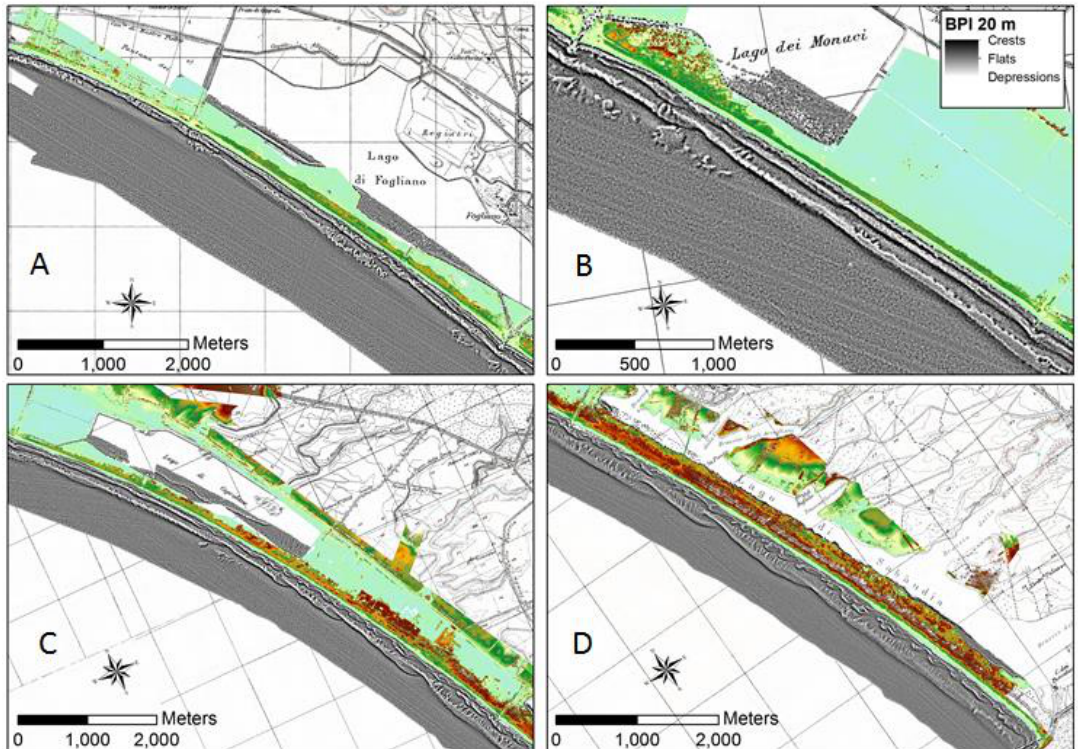
Figure 7. Bathymetric Position Index calculated from DSM. Four examples of bedforms are visualized from North to South: ( A ) two main crests running parallel to the shoreline; ( B ) the two crests in ( A ) become more complex; ( C ) the crest closer to the shoreline shows a higher sinuosity, while the farthest shows a higher distance from the shoreline; ( D ) series of small regular cross-shore structures, perpendicular to the shoreline. Note the increasing distance of the bar crests from the shoreline moving southward.